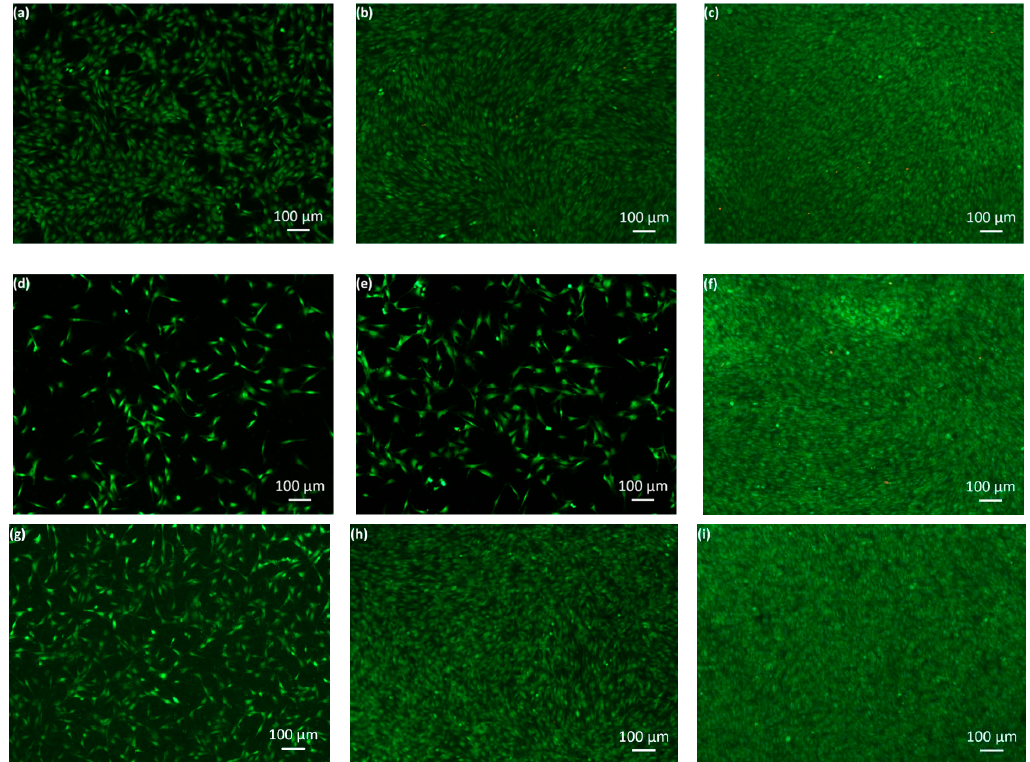
Figure 7. Representative live/dead staining images for austenitic stainless steel disks coated with ( a – c ) an un-doped SiO x film, ( d – f ) a Zn-SiO x film grown at a secondary precursor flow rate of 100 µl/min, and ( g – i ) a Cu-SiO x film grown at 50 µl/min on the first ( a, d, g ), third ( b, e, h ), and seventh